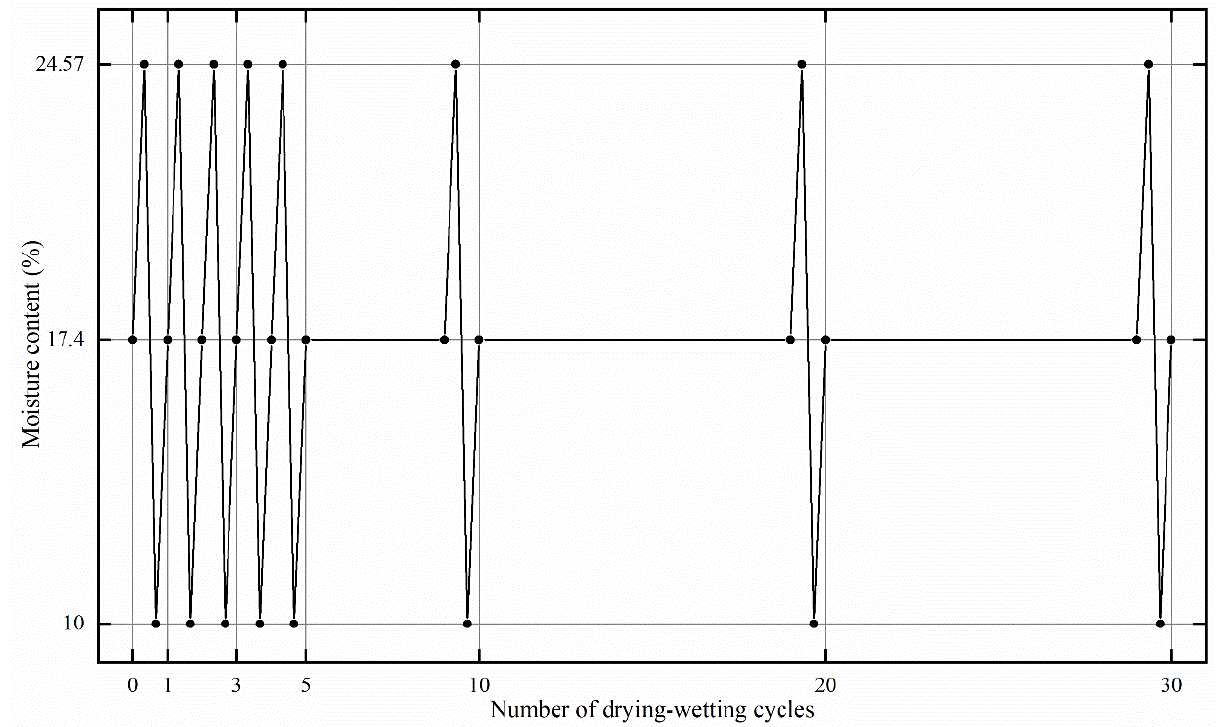
Figure 3. Illustration of drying–wetting cyclic process.